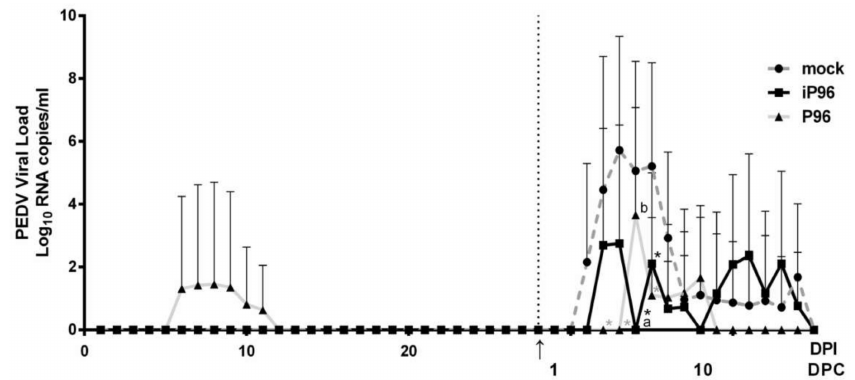
Figure 4. The mean value of RNA copies in the feces of piglets inoculated with the iPEDVPT-P96 virus ( (cid:4) ), the PEDVPT-P96 virus ( (cid:78) ), or mock-inoculated ( ) through the study. Each group consists of 5 piglets. The dashed line and arrow indicated the time point (28 DPI or 0 DPC) at which pigs were challenged with the PEDVPT-P5 virus. The error bars indicated standard deviation. Data were analyzed using two-way ANOVA by time. Significant differences with the mock group were labeled with asterisks ( p < 0.05). Different alphabetic letters indicate significant differences between the iPEDVPT-P96 or PEDVPT-P96 groups ( p < 0.05). iP96: PEDVPT-P96; PEDVPT-P5; P96: PEDVPT-P96